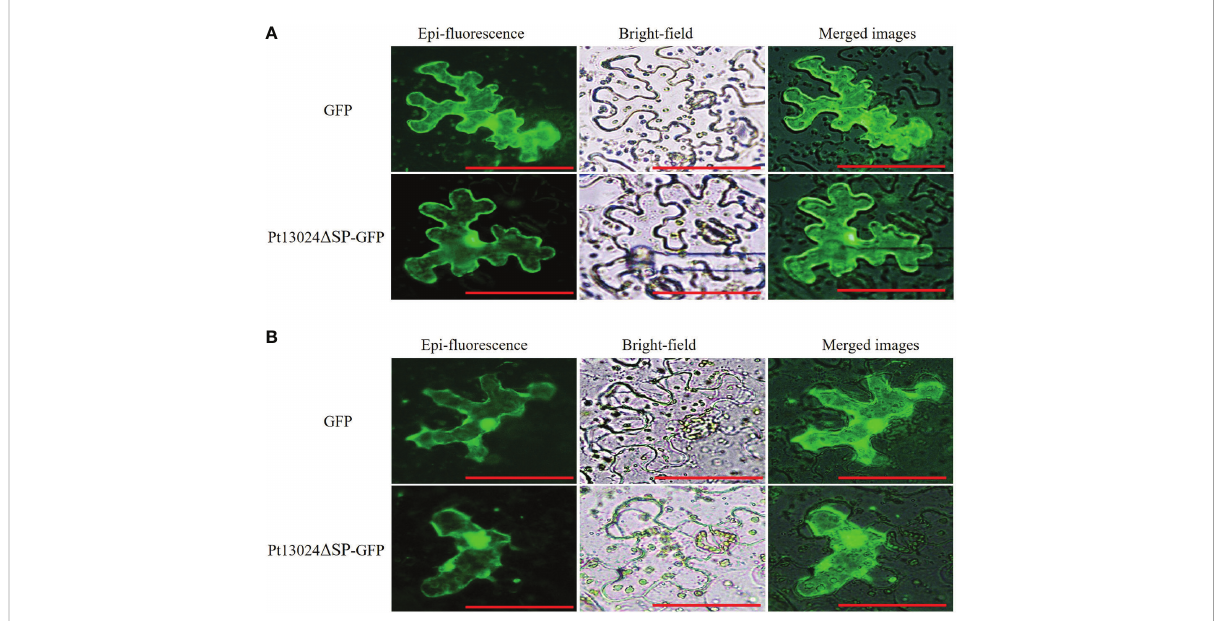
FIGURE 3 Pt13024 is localized to the N. benthamiana cytoplasm and nucleus. (A) Transient co-expression of the Pt13024 D SP : GFP and GFP alone in leaf tissues of N. benthamiana was examined using a Nikon Ti2-U epi fl uorescence microscope (Nikon Corporation, Japan). Bar = 10 m m. (B) The epidermis of N. benthamiana leaves was removed and soaked in 0.8M mannitol to achieve the purpose of plasmolysis. A Nikon Ti2-U fl uorescence microscope (Nikon Corporation, Japan) was used to observe the expression levels and localization of effector proteins. GFP, green fl uorescent protein.